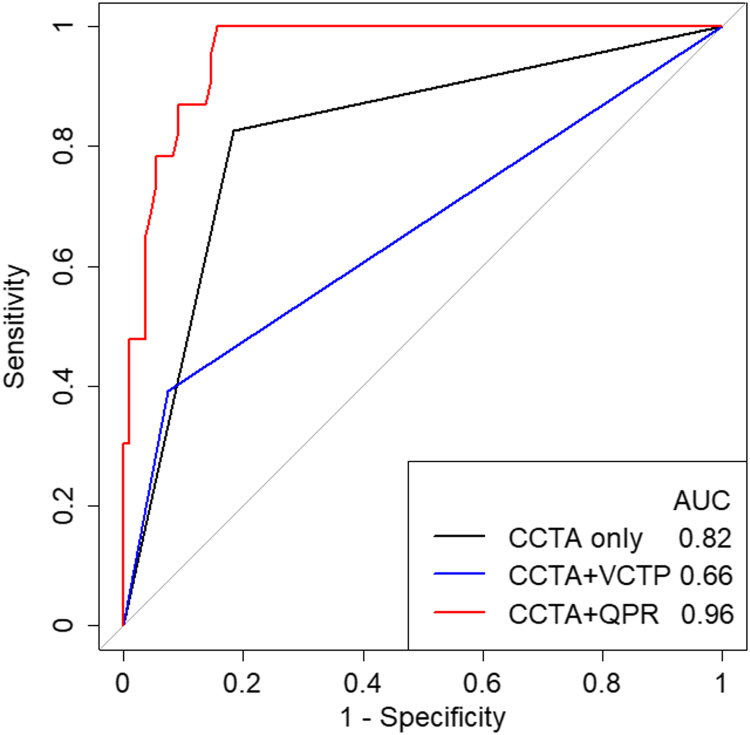
The area under the curve including QPR for analysis (red line, 0.96, 95%CI, 0.93—0.99) was significantly larger (p <0.01) than that of CCTA alone (black line, 0.82, 95%CI, 0.73—0.91) and CCTA + visual CTP (blue line, 0.66, 95%CI, 0.55—0.76). CCTA, coronary computed tomography angiography; CI, confidence interval; QCA, quantitative coronary analysis; QPR, quantitative perfusion ratio; VCTP, visual computed tomography perfusion.